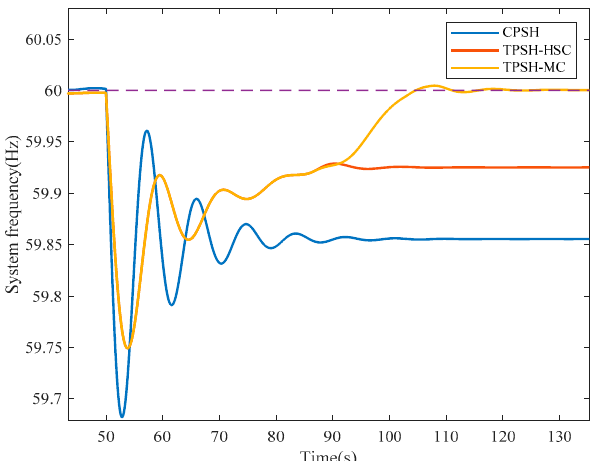
Figure 8. Comparison of CPSH, TPSH in HSC mode (TPSH-HSC), and TPSH with HSC and mode change capability (TPSH-MC) with PV.